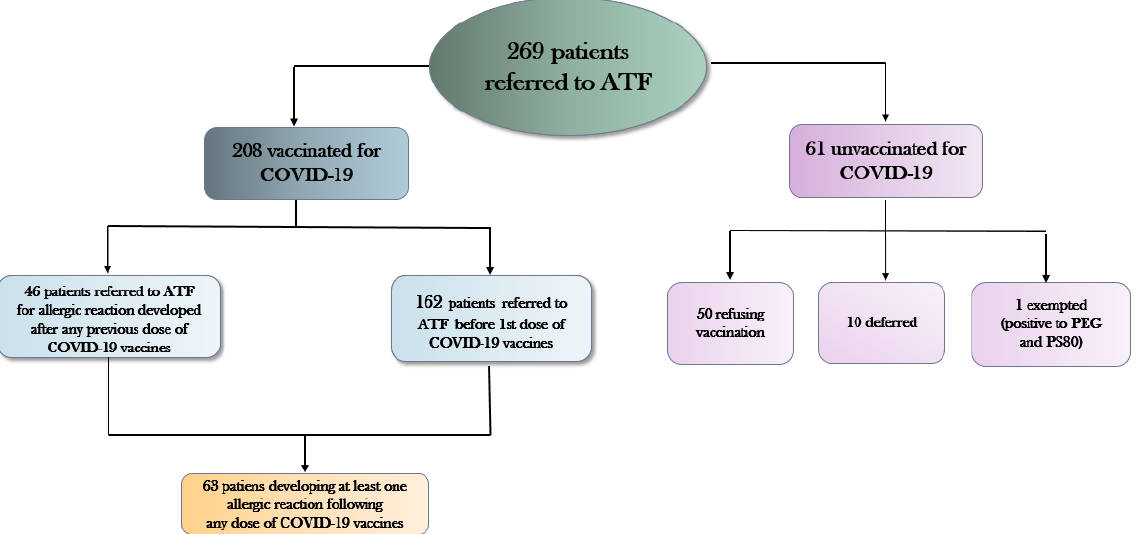
Figure 1. Patients with history of allergic reactions referred to the allergy task force (ATF) of Trieste from March 2021 to February 2022. PEG = polyethylene glycol; PS80 = polysorbate 80. Table 1. Distribution of the study population. Number (N); column percentage (Col %); mean As can be seen from Table 1, high-risk allergic patients of ASUGI Trieste were pre- (M) ± standard deviation (SD); median and interquartile range (IQR). PS80 = Polysorbate 80. dominantly females (79.6%) and had a median age of 55 years (IQR: 45 – 64 years). Moreo- ver, 53.5% of patients had a history of drug allergy and 49 (18.2%) reported drug anaphy- laxis. Food allergy was reported by 69 (25.6%) patients and 7 more developed food ana- phylaxis. Eighteen patients underwent skin tests for PEG, of which none were positive, whereas three were tested for PS80 with only one turning up positive.